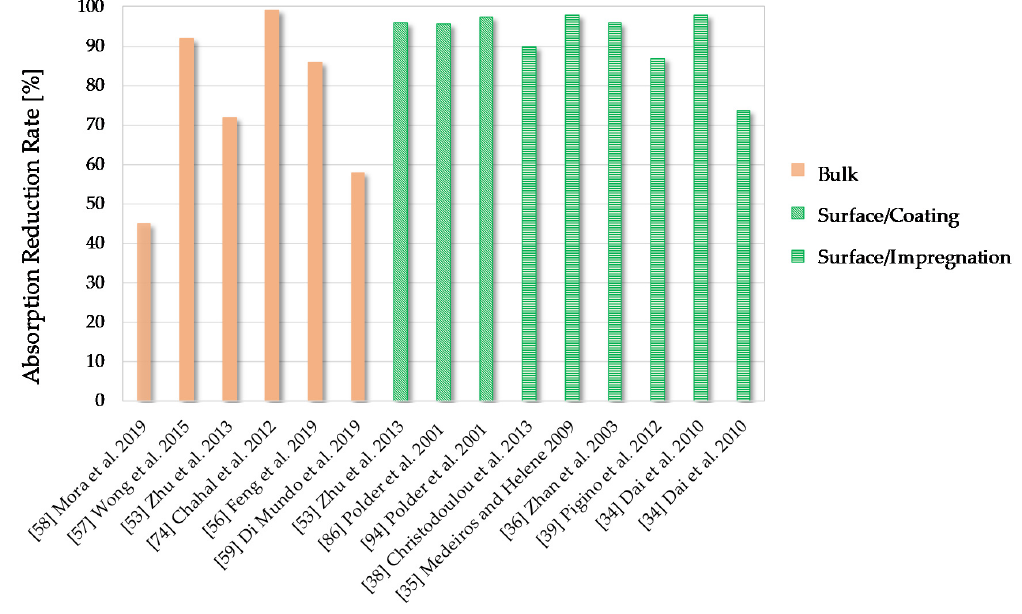
Figure 19. Review on water absorption reduction rate reported in the literature about hydrophobic modifications on concrete.